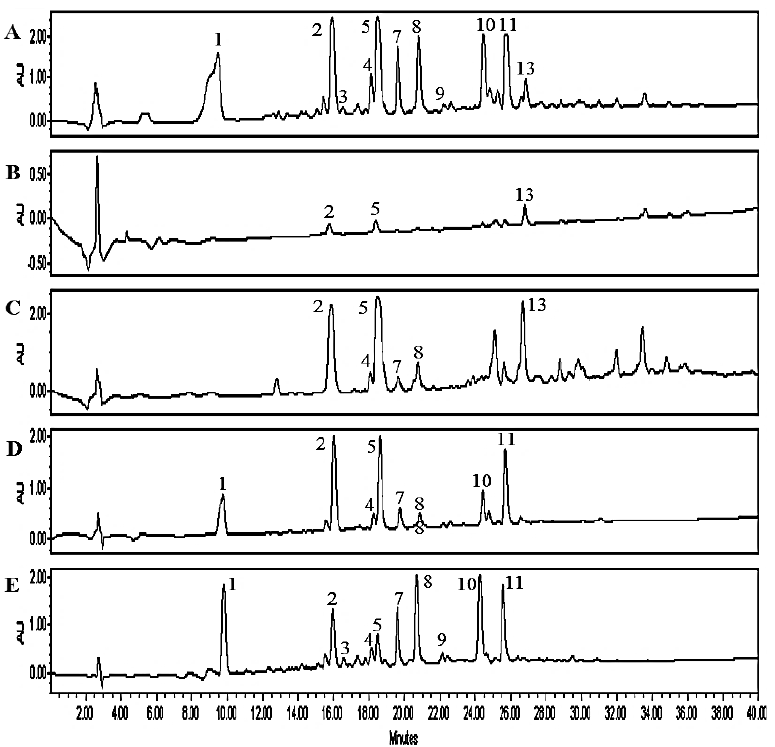
Figure 3. HPLC (220 nm) profile of solvent fractionation obtained from 70% MeOH extract of M. tricuspidata twig. ( A ) 70% MeOH extract; ( B ) n -hexane fraction; ( C ) ethyl acetate fraction; ( D ) n -butanol fraction; ( E ) water fraction; 1 , gastrodin; 2 , taxifolin-7- β - D -glucoside; 3 , parishin E; 4 , chlorogenic acid; 5 , dihydrokaempferol-7- β - D -glucoside; 7 , unknown-1; 8 , parishin B; 9 , parishin C; 10 , parishin A; 11 , unknown-2; 13 , kaempferol-3- β - D -glucoside.